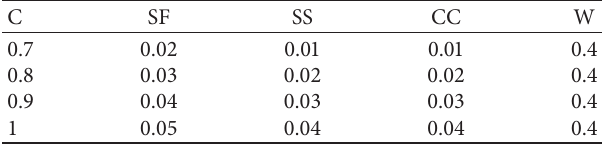
Table 1: Ratio for green fly ash-based grouting